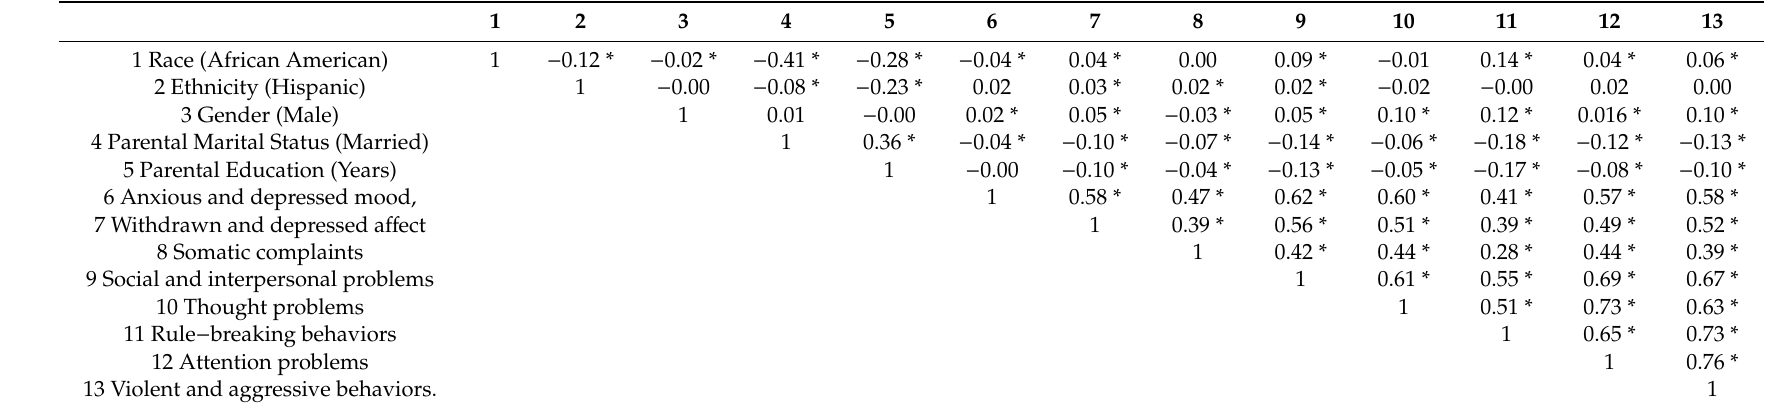
Table 3. Bivariate correlations in the pooled sample.